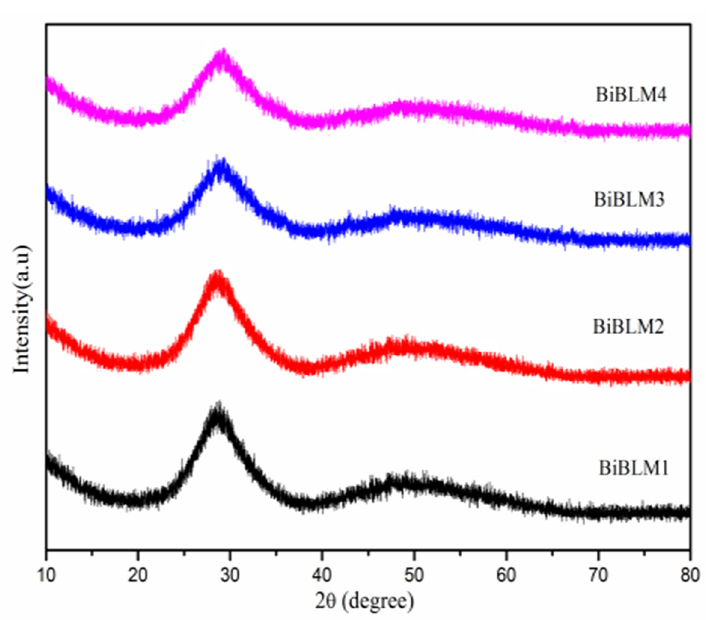
Figure 3. X-ray diffraction of BiBLM glass system.